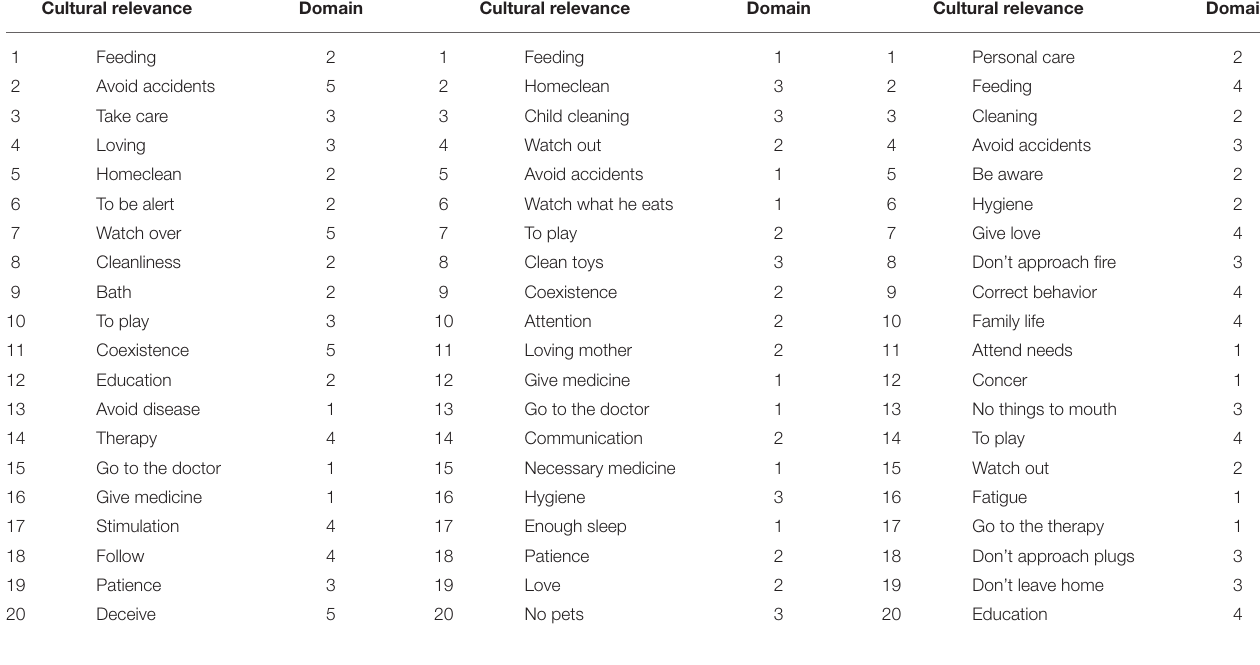
TABLE 3 | Cultural relevance of food and Consensus of cultural domains of “child care,” according to group of caregivers. Cultural relevance (CR) Cultural consensus Group Place of the feeding Value of CR Factor 1 (F1)* and % of Factor 2 (F2) and % of Ratio F1/F2** between the 20 elements cumulative variance cumulative variance 1 First n = 38